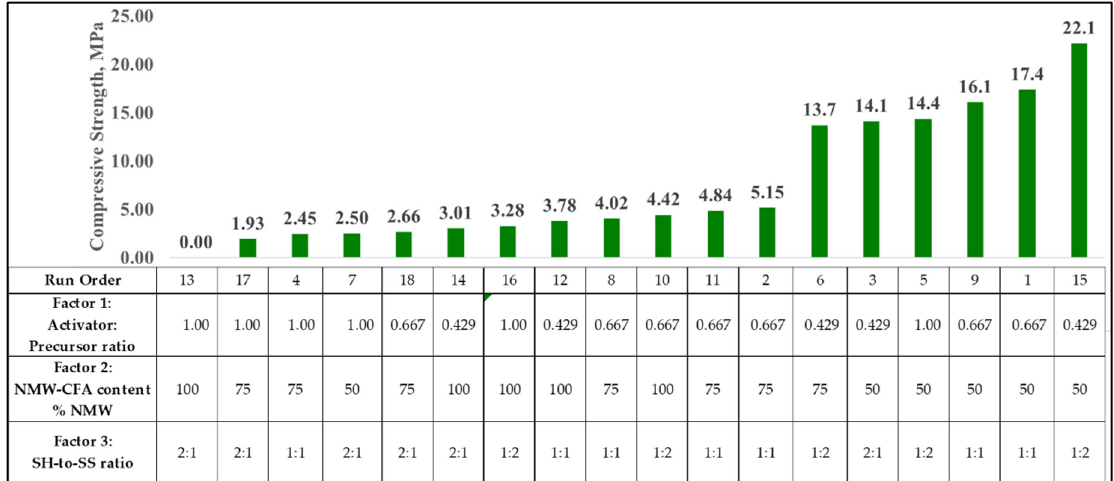
Figure 4. Comparison of unconfined compressive strength at different mix proportions.